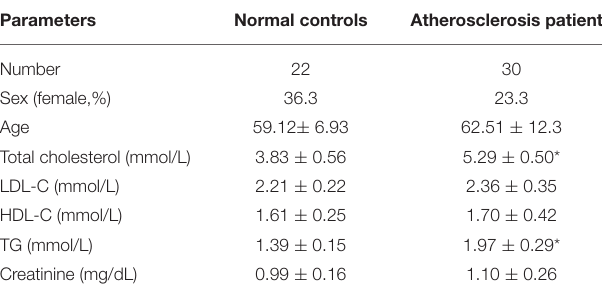
TABLE 1 | Clinical parameters of athersclerosis